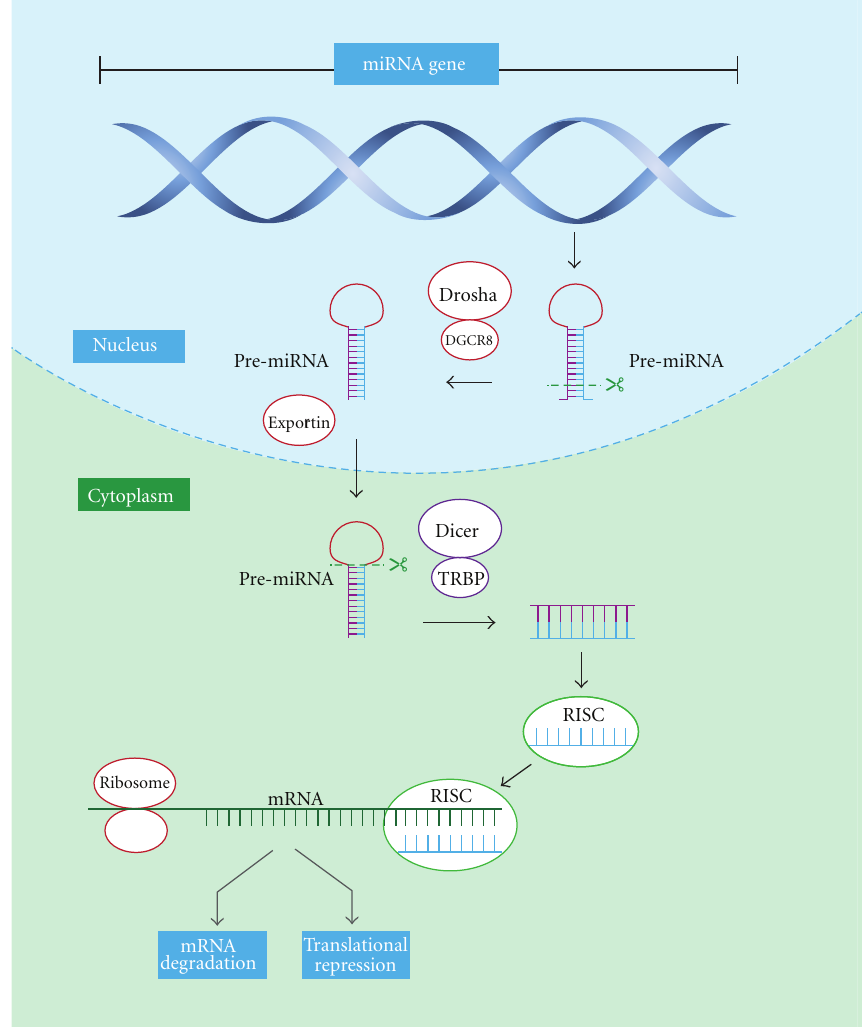
Figure 5: miRNA biogenesis. miRNA genes are transcribed by RNA Polymerase II in the nucleus to form a primary miRNA (pri-miRNA) that is, 100 to 1000 nucleotides in length. This pri-miRNA is recognized by nuclear enzymes Drosha, Pasha, or DGCR8 (in humans), which cleave about 11 nucleotides o ff of it to produce hairpin structures known as pre-miRNA, which are ∼ 70 nucleotides in length. Once pre-miRNA hairpins are made, they are exported from the nucleus to the cytoplasm by the Exportin-5 enzyme. In the cytoplasm, the Dicer enzyme cleaves pre-miRNAs to form a duplex miRNA that is 18–23 nucleotides in length. Of these 2 strands, the one with lower stability in the 5 (cid:3) end is the guide strand, and it will be associated with the RNA-induced silencing complex (RISC), where miRNAs interact with the mRNA targets. The RISC complex needs to interact with other proteins such as Argonaute (Ago) proteins and TRBP to function appropriately. The translational repression and target degradation of mRNAs can be achieved by the level of complementarity between miRNAs strand and the site in the 3 (cid:3) UTR targets. If there is a complete complementation, there will be a cleavage of the mRNAs and it will produce the degradation. On the other hand, if there is an incomplete complementation, translation will be repressed by taking the transcripts into P bodies to keep them